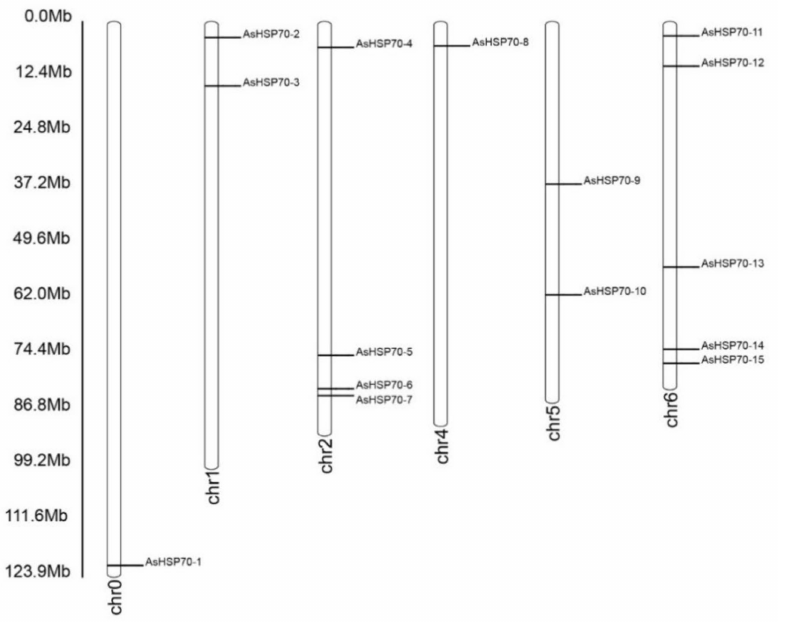
Figure 2. Chromosomal location of AsHSP70 in A. sinensis . The chromosome number is indicated at the bottom of each chromosome. The bar located on the left side indicates the chromosome sizes in mega bases